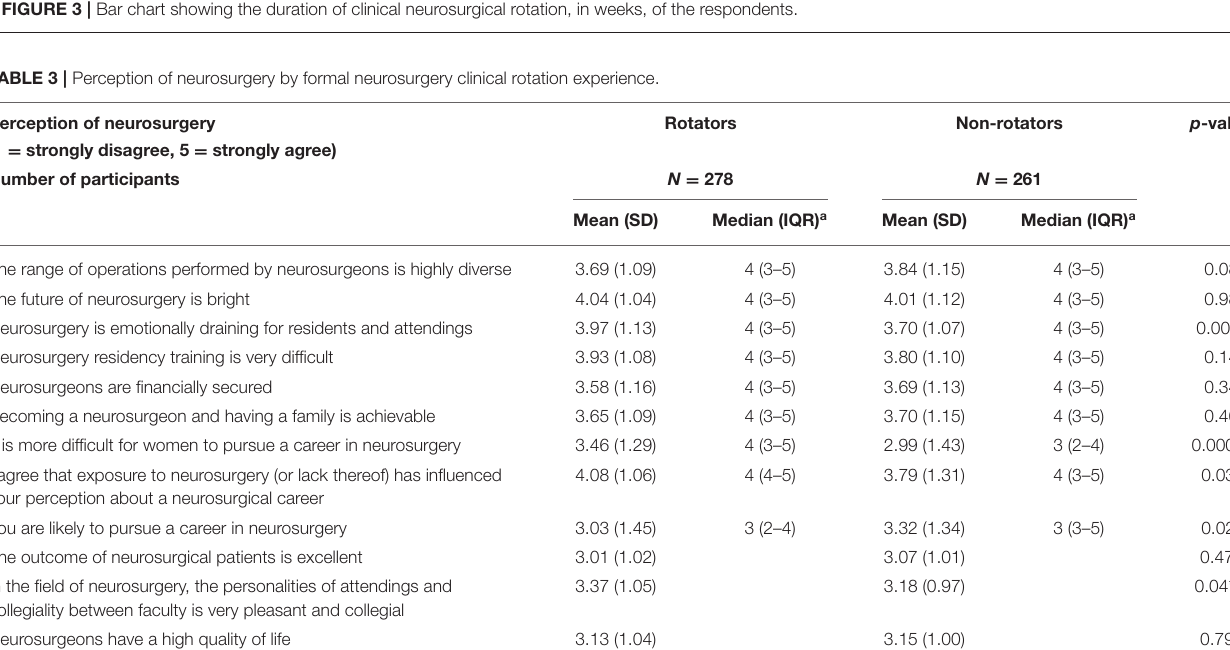
FIGURE 3 | Bar chart showing the duration of clinical neurosurgical rotation, in weeks, of the respondents.